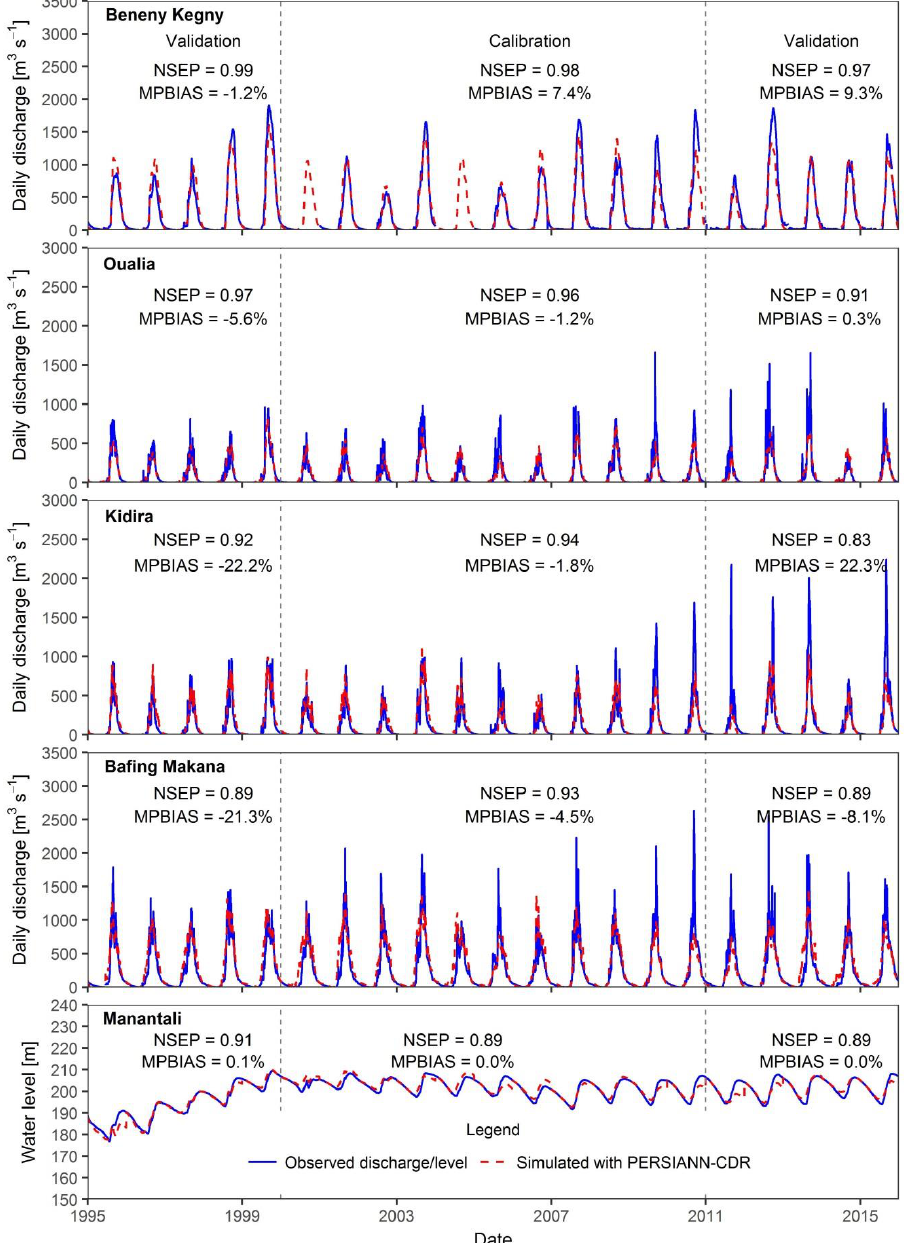
Figure 5. Observed and simulated discharges and water level using original PERSIANN-CDR